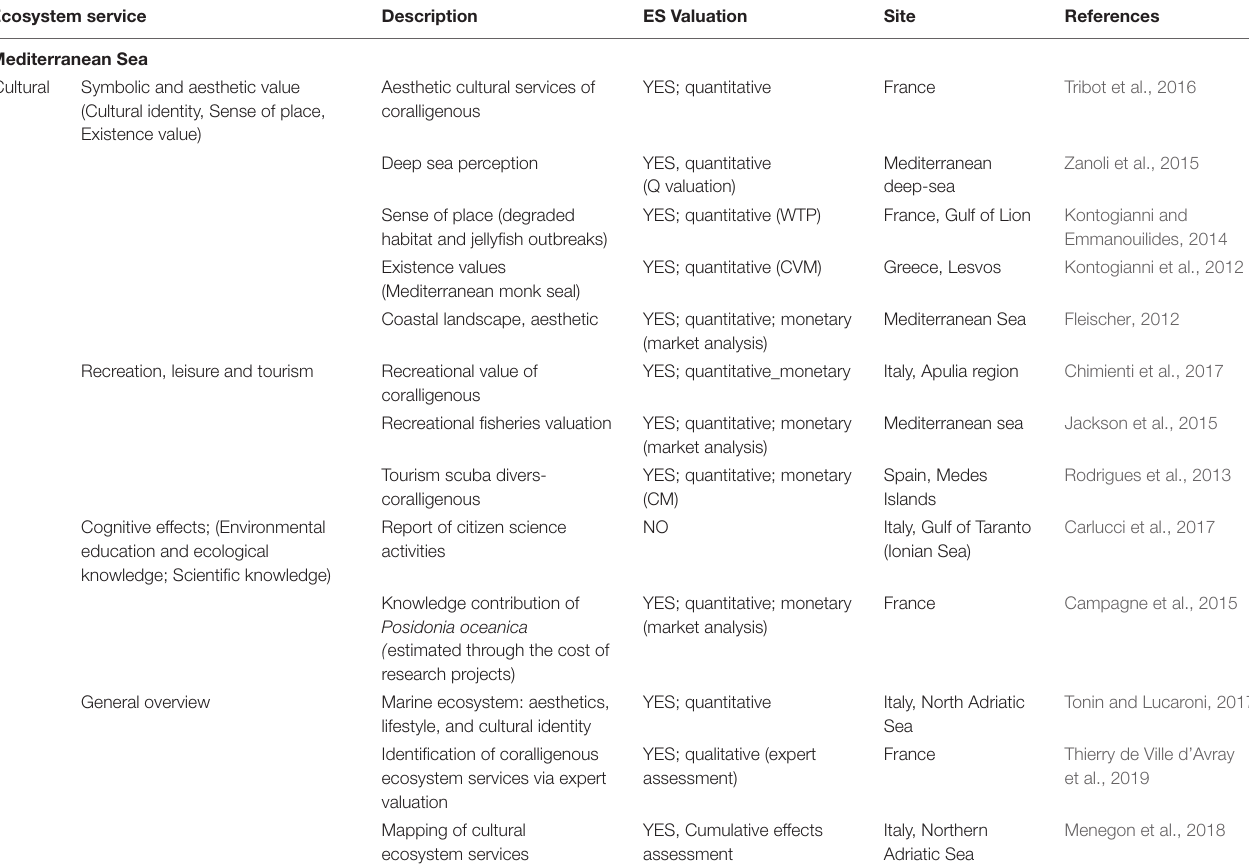
TABLE 2 | Review of the marine CES in the Mediterranean